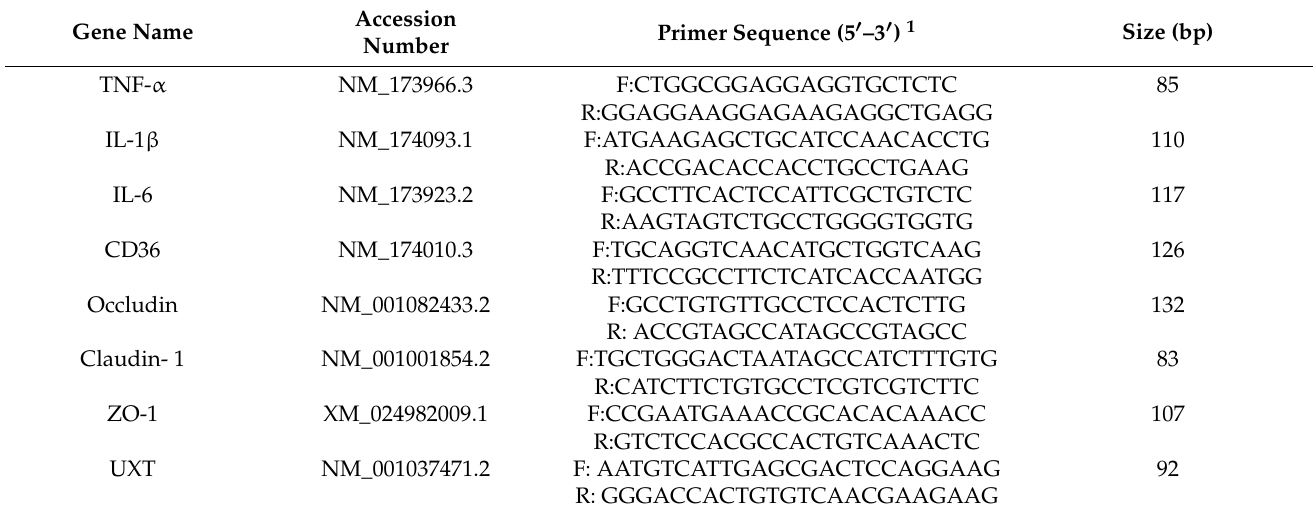
Table 1. Primer sequences of quantitative reverse transcription